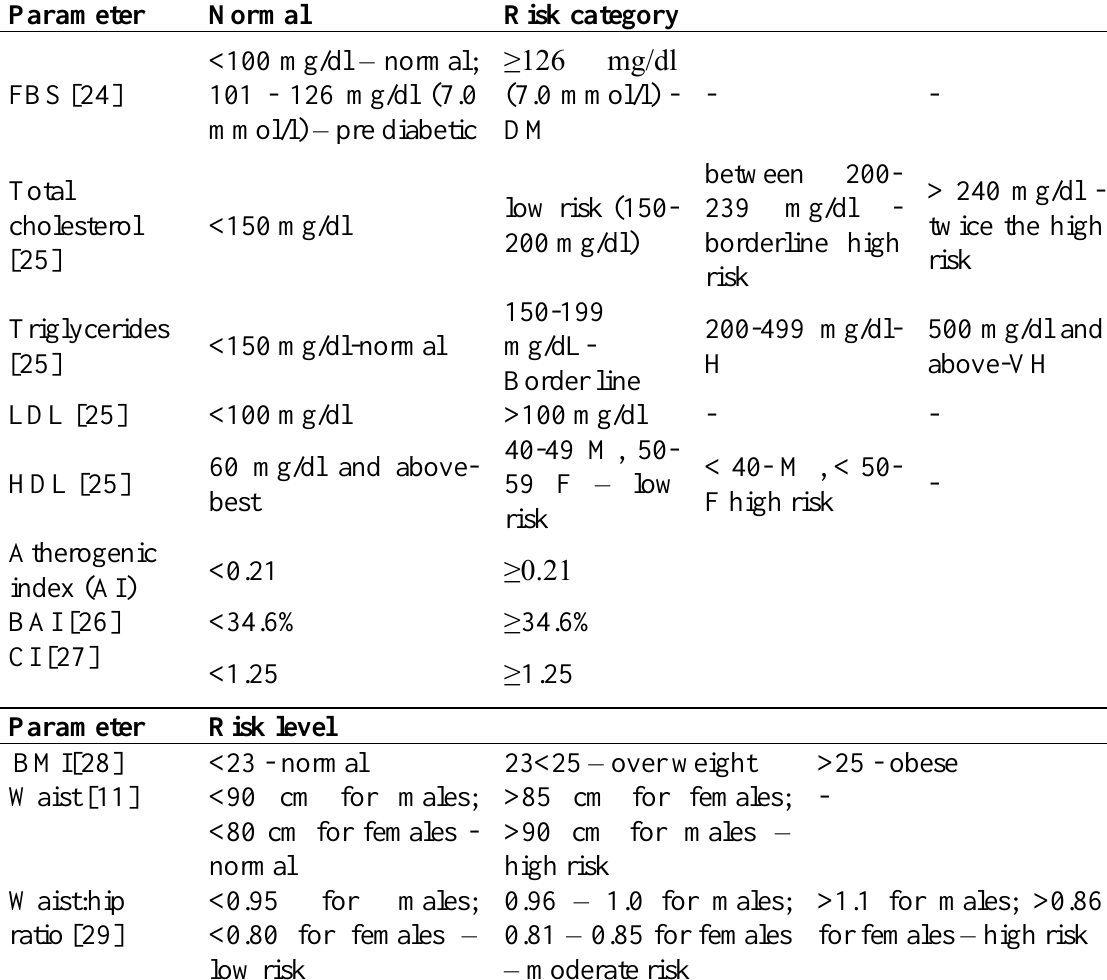
Table 1: Cutoff values